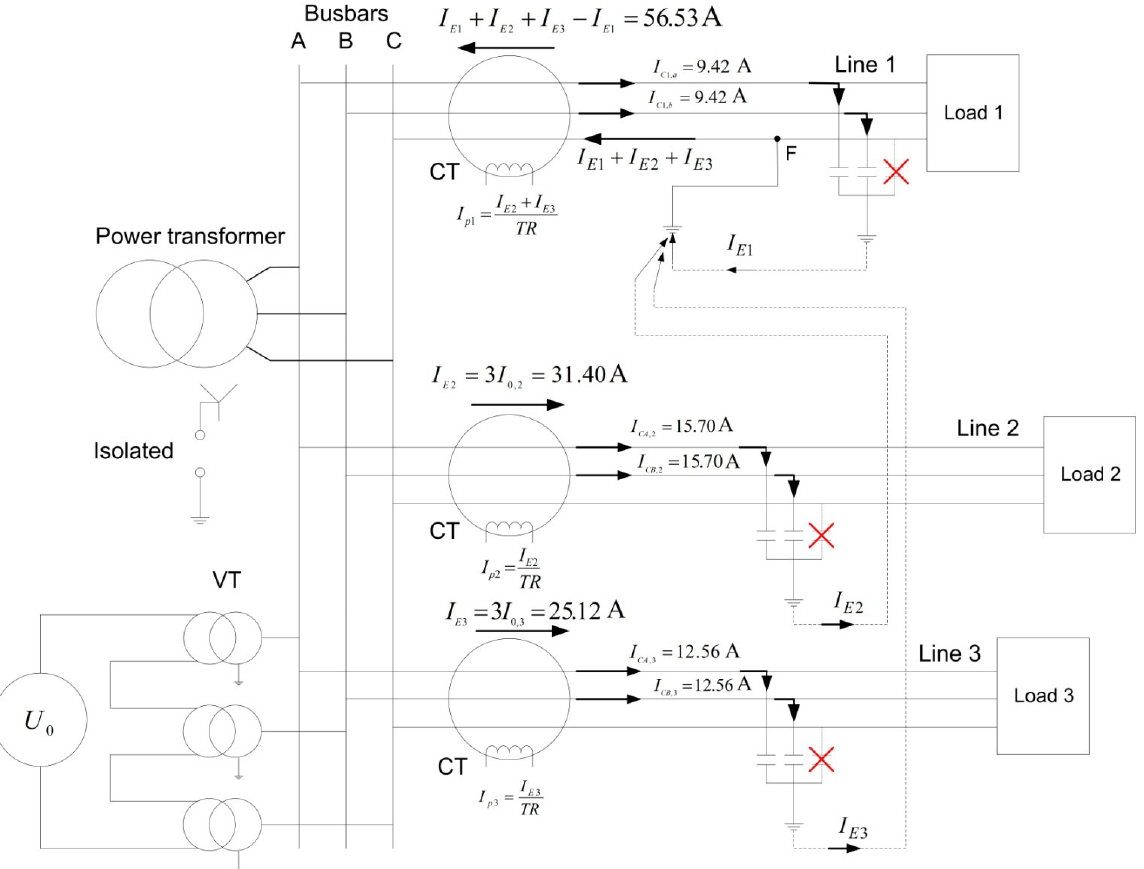
Figure 2. Residual current distribution in a three line neutral ungrounded system with ground fault at F in phase “ c ” of Line